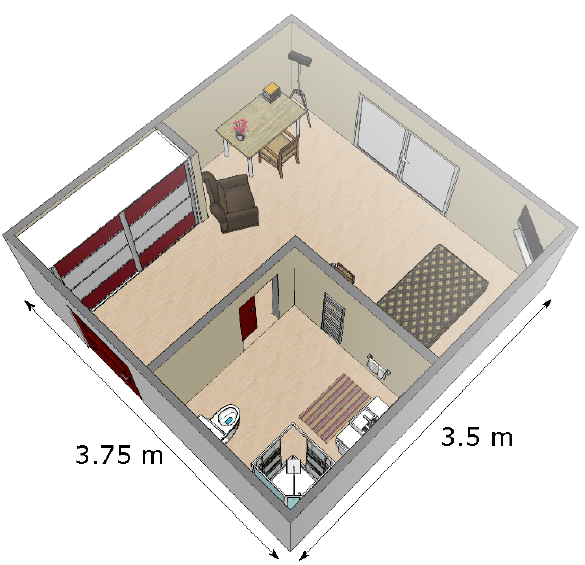
Figure 1. Representation of a typical patient’s room. The sensor was positioned in the corner at the top of the